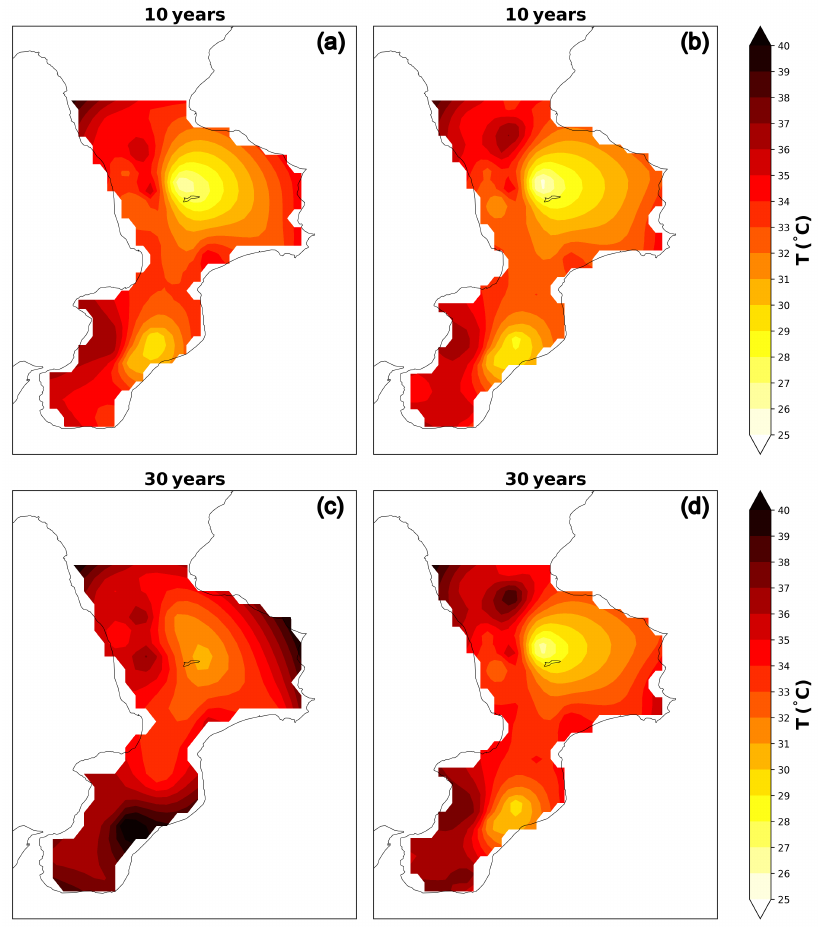
Figure 6. Comparison between daily max temperature return-level maps for return period of 10 and 30 years. Return-level map for the observed data ( a , c ) and from the BM model ( b , d